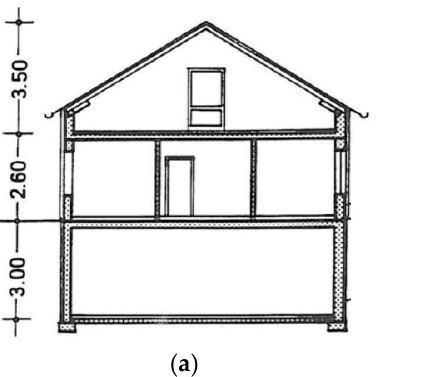
Figure 4. Determined heat power for a 100 m 2 building simulated in TRNSYS.